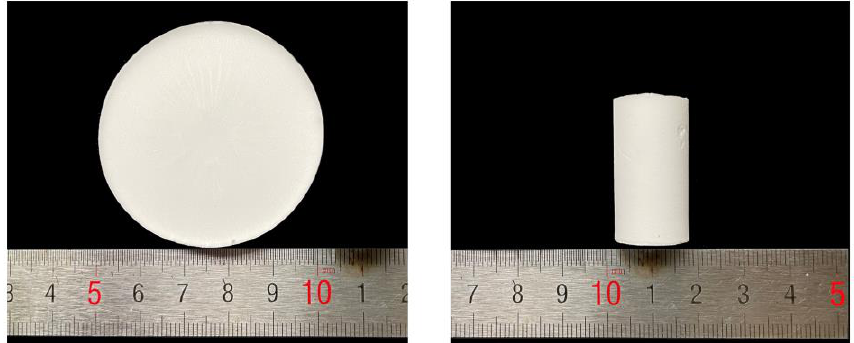
Figure 9. The pie-like and cylindrical MSAs.